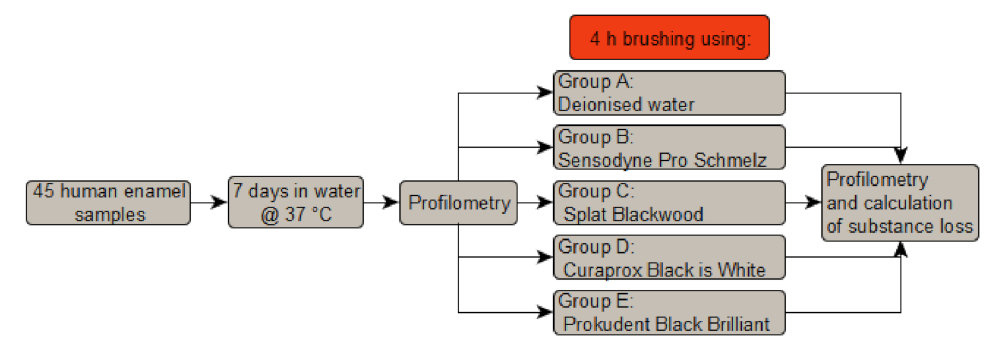
Figure 1. Study design.